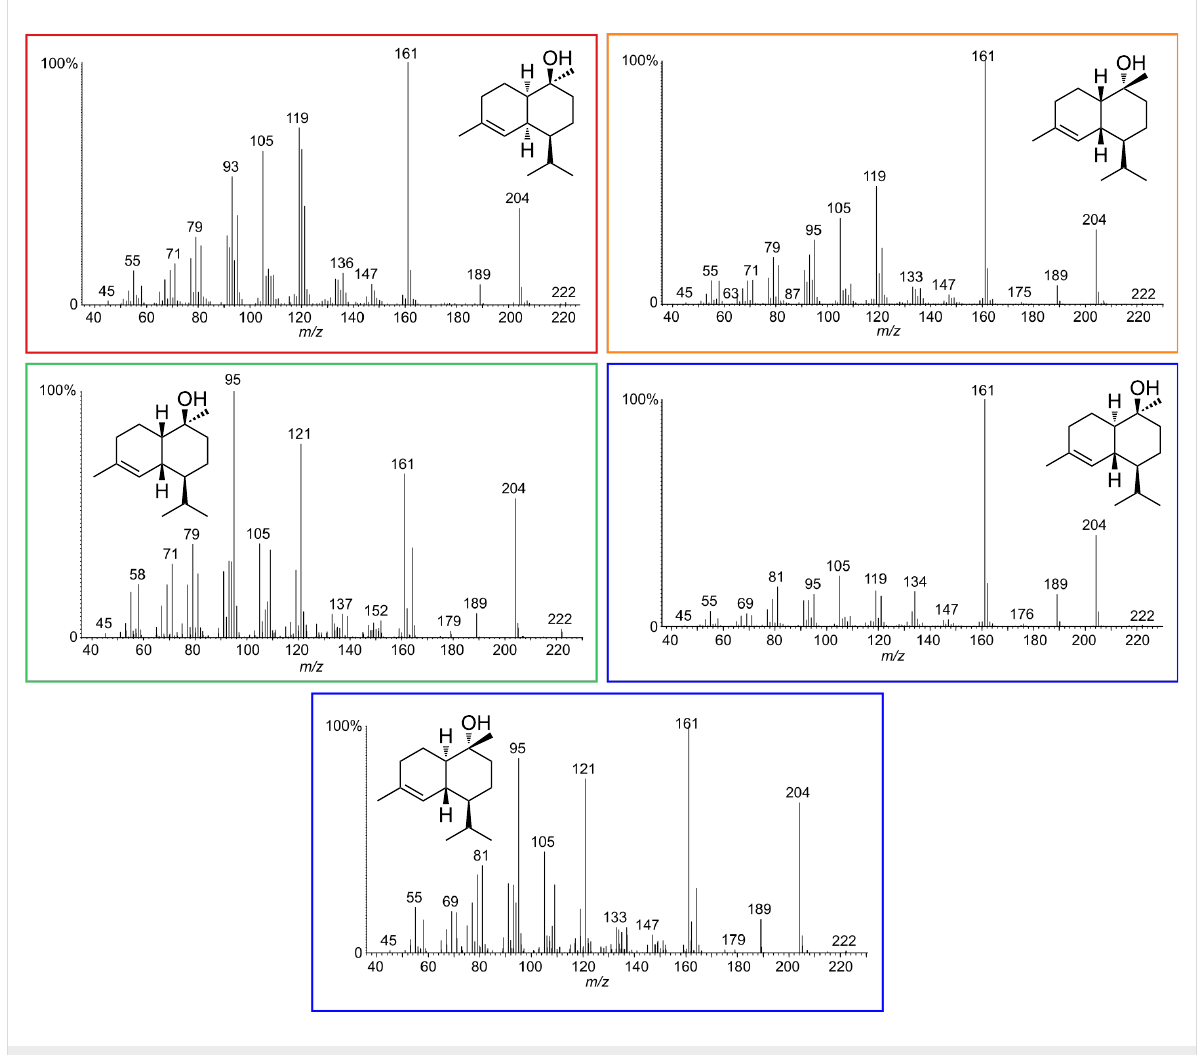
Figure 7: Mass spectra of each cadinol-type diastereomer. The box colors refer to the peaks and compounds in Figure 5.